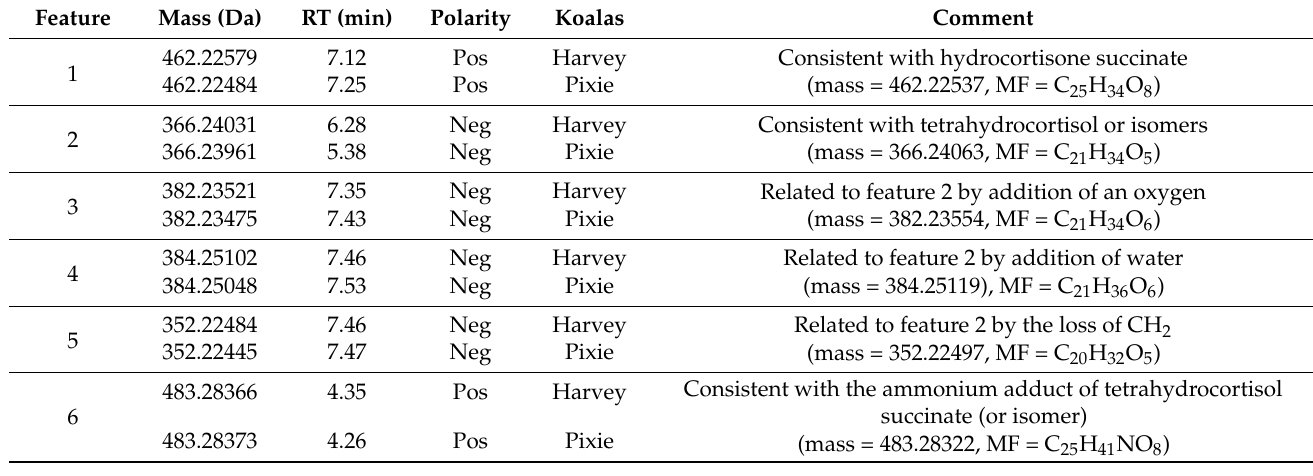
Table 1. Chromatographic features detected in the untargeted LC-MS analysis that were elevated in the samples following administration of cortisol.